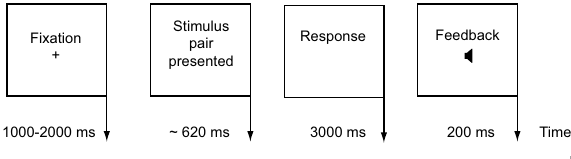
Figure 2. Example trial of the associative learning task. Temporal sequence of a single experimental paired associate learning